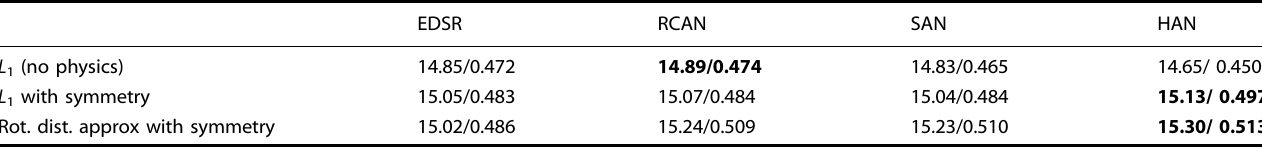
Table 1. PSNR/SSIM comparison for 4 × super-resolution scaling: physics-based loss consistently outperforms bilinear, bicubic, nearest neighbor, and pure L 1 loss with no physics, regardless of architecture.